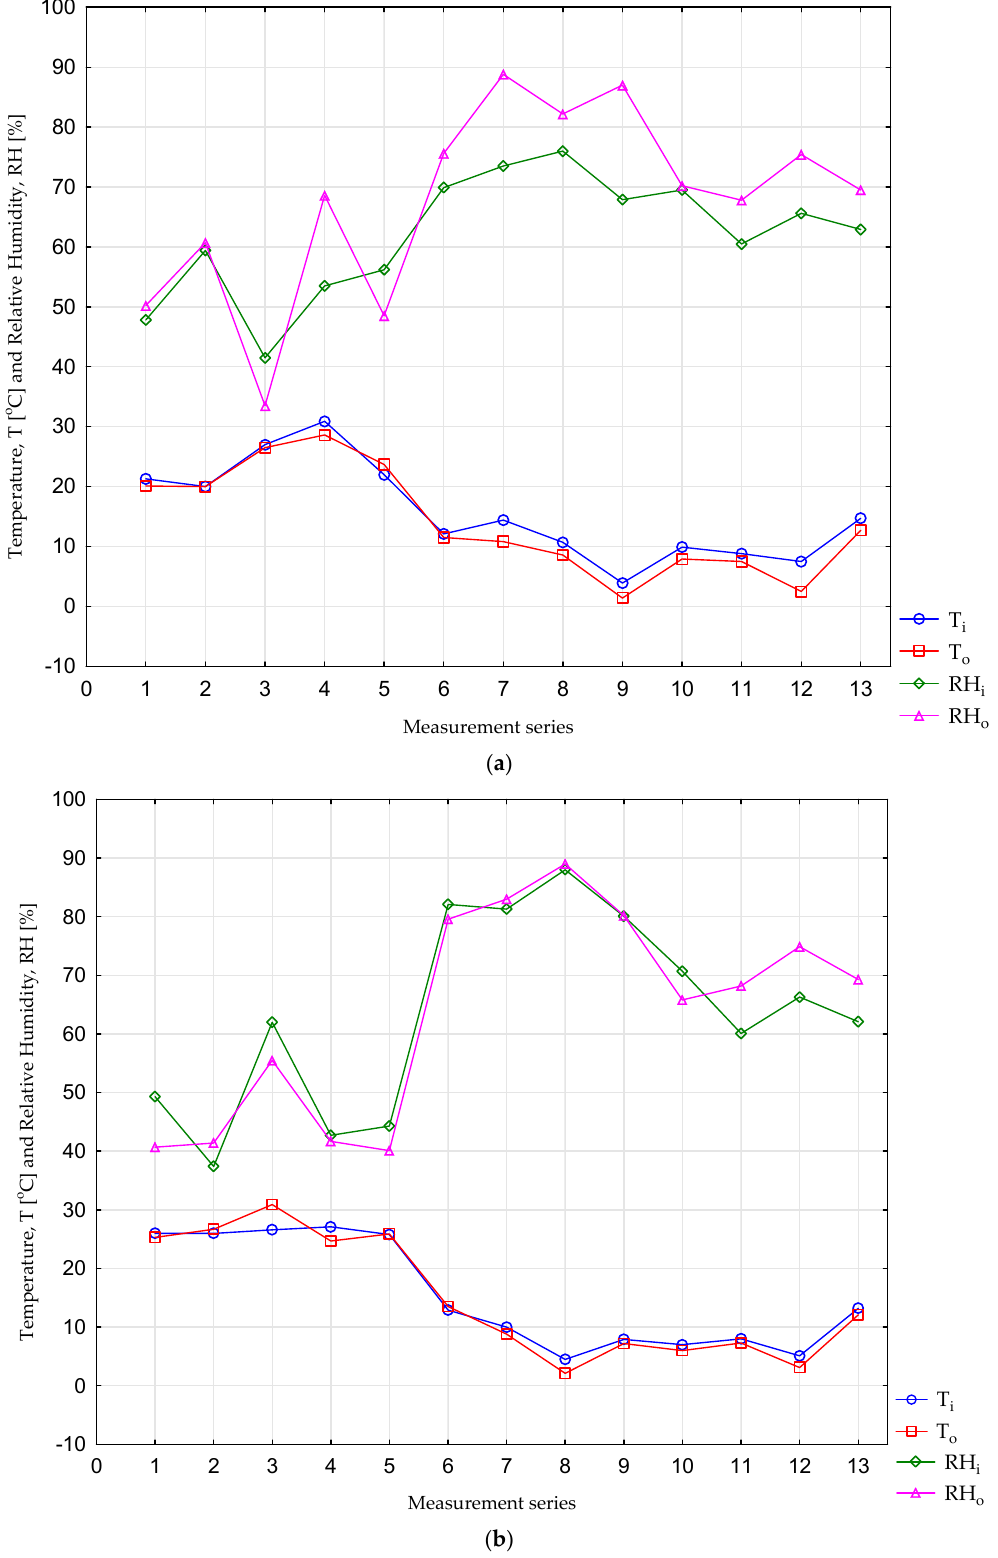
Figure 3. Inside and outside temperature (T) and relative humidity (RH) at biogas plant A ( a ) and biogas plant B ( b ) at individual measurement